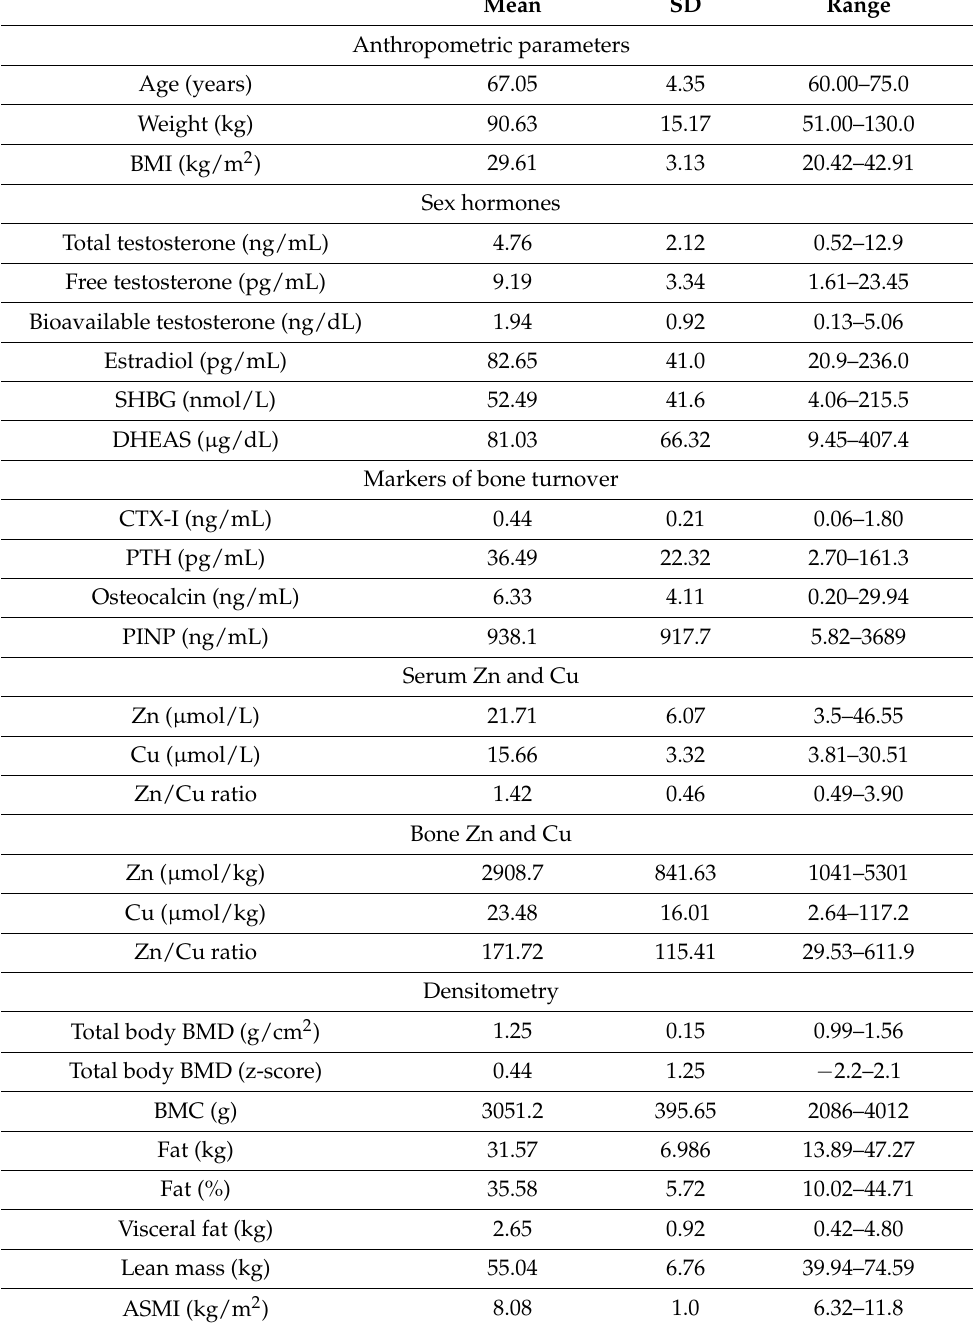
Table 1. Baseline characteristics of study